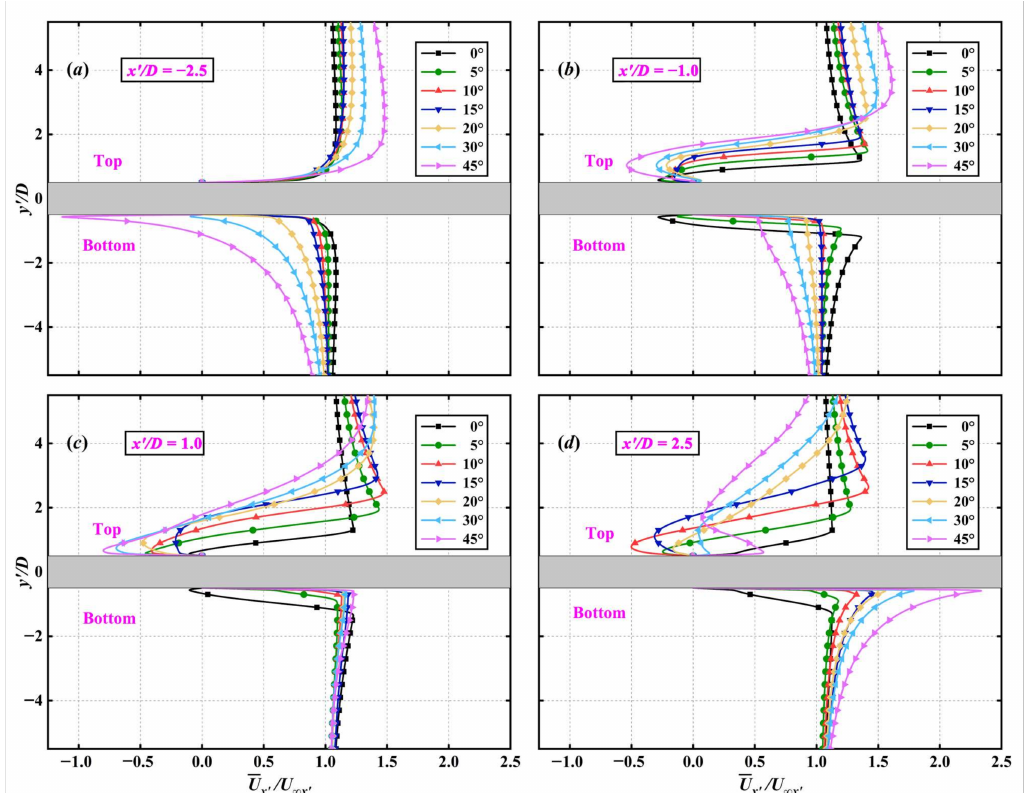
Figure 14. Time-averaged velocity U x (cid:48) distribution of each section. ( a ) x (cid:48) /D = − 2.5, ( b ) x (cid:48) /D = − 1.0, ( c ) x (cid:48) /D = 1.0, ( d ) x (cid:48) /D = 2.5.